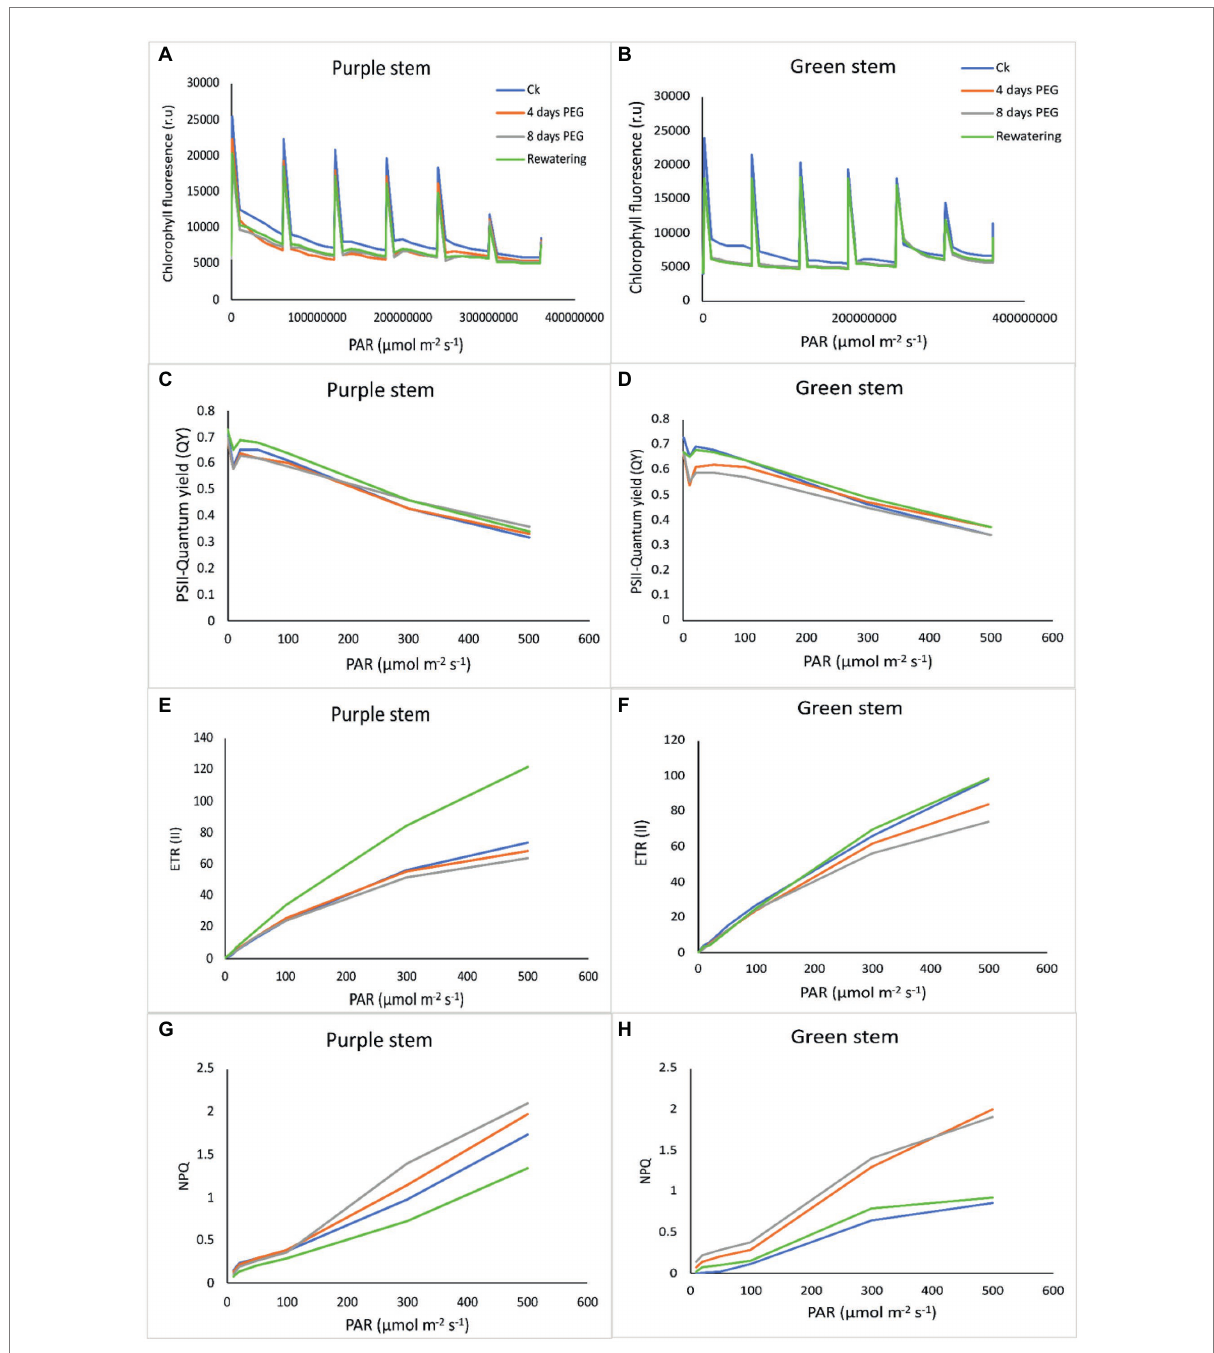
FIGURE 4 Purple and green stem Brassica napus plants under drought (10% PEG-6000), (A,B) chlorophyll fluorescence (r.u), (C,D) PSII quantum yield (QY), (E,F) electron transport rate (ETR II), and (G,H) non-photochemical uenching (NPQ),